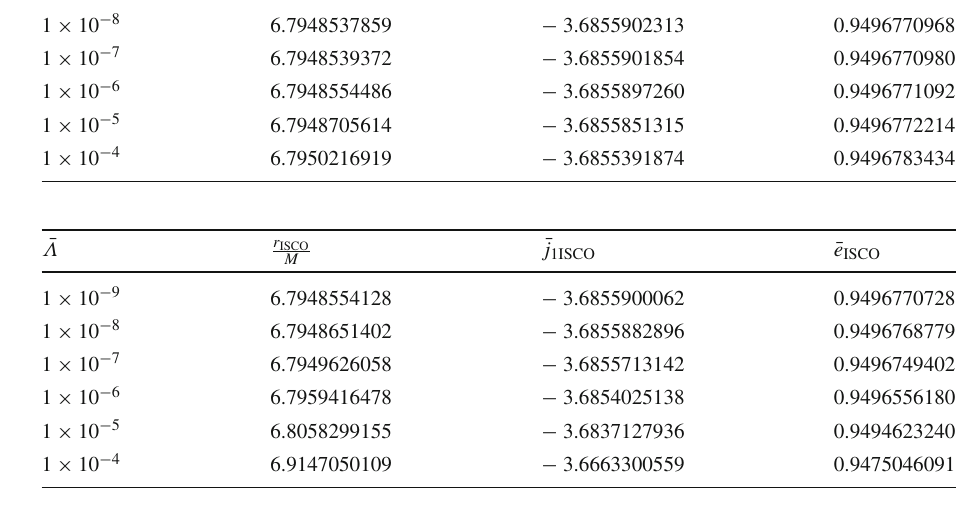
orbit) parameters of the spinning test particle in the black hole background with a = 0 . 25 and ¯ Λ = 0